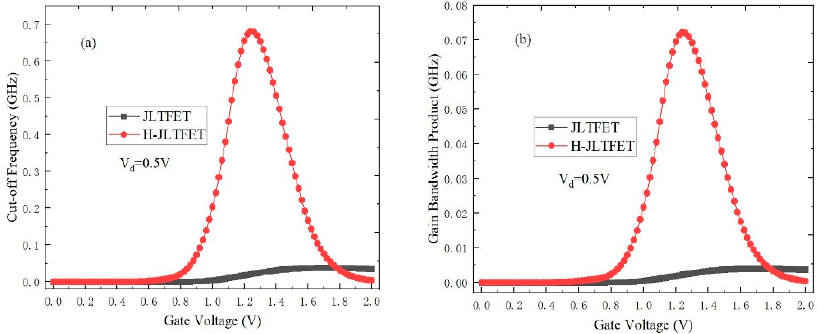
Figure 10. ( a ) Cutoff frequency; and ( b ) gain bandwidth product of the JLTFET and